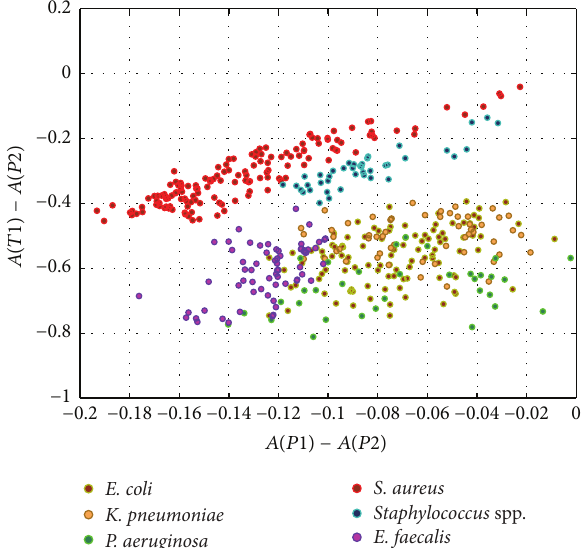
Figure 3: Scatter plot of the 𝐴(𝑃1) − 𝐴(𝑃2) difference versus the 𝐴(𝑇1)−𝐴(𝑃2) characteristics of multiwavelength angular scattering spectra of target species training sets.